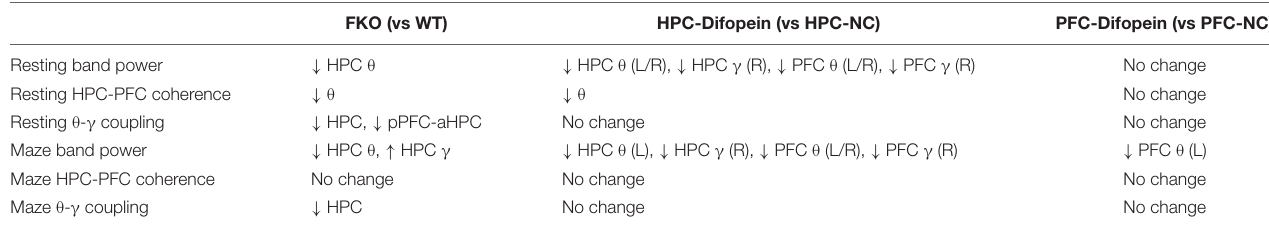
For virus models, the hemisphere(s) where significant differences were observed are indicated (left, right, or both). pPFC, PFC phase. aHPC, HPC amplitude.